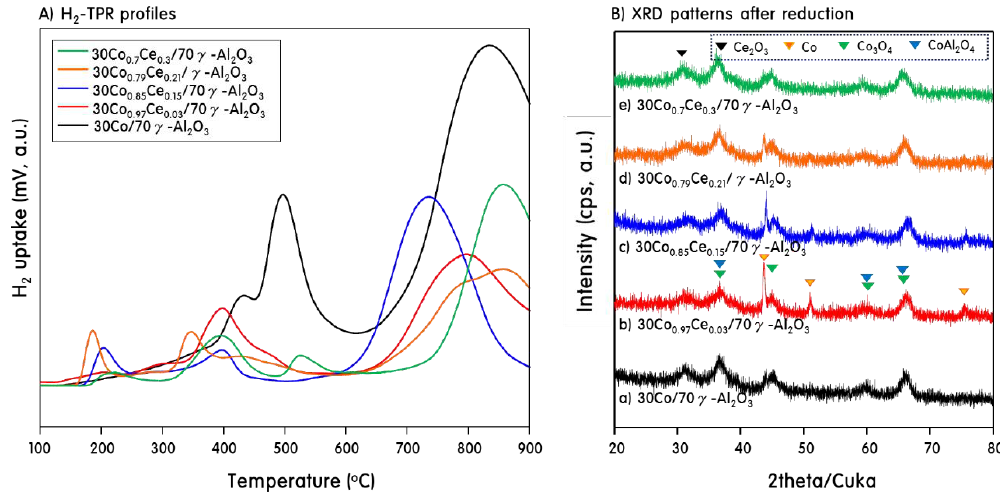
Figure 4. H 2 -TPR curves of the fresh 30Co x Ce y /70 γ -Al 2 O 3 catalysts and XRD patterns of the reduced Figure 4. H 2 ‐TPR curves of the fresh 30Co x Ce y /70γ-Al 2 O 3 catalysts and XRD patterns of the reduced 30Co x Ce y /70 γ -Al 2 O 3 30Co x Ce y /70γ-Al 2 O 3 catalysts.